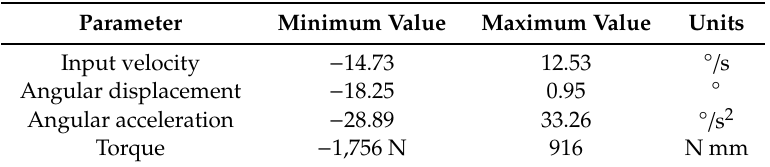
Figure 5. Input velocities and computed results of the dynamic simulation where the mechanism perform the exercise to trace the number 8: ( a ) Input velocities; ( b ) Angular displacements; ( c ) Angular accelerations; and ( d ) Motors torques. Table 4. Dynamic analysis results for motor 1.